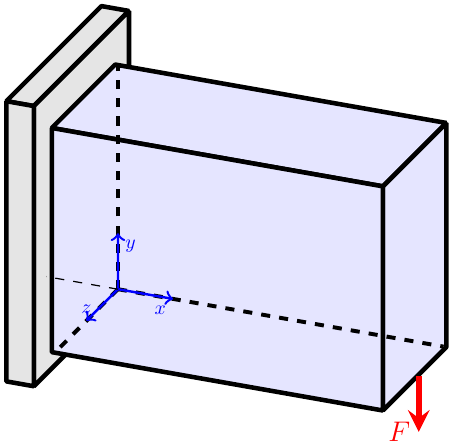
Figure 2. Design domain of deep cantilever